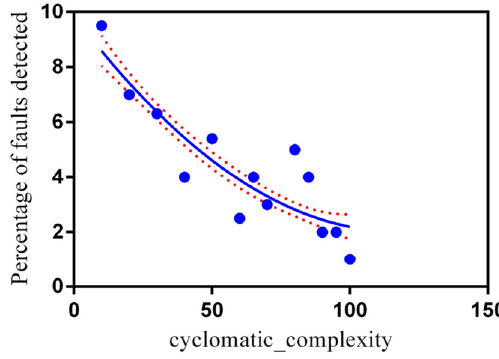
Fig. 9 Complexity-fault analysis of PSO (Spearman r s = − 0 . 8)